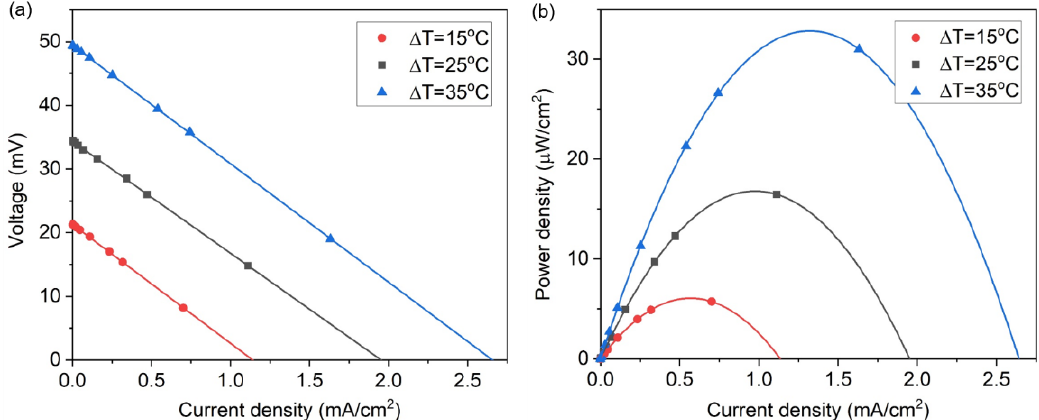
Figure 3. Measurement of thermocell performance according to the temperature difference at the electrodes: ( a ) J-V curves of the thermocell; ( b ) power density produced by the thermocell.